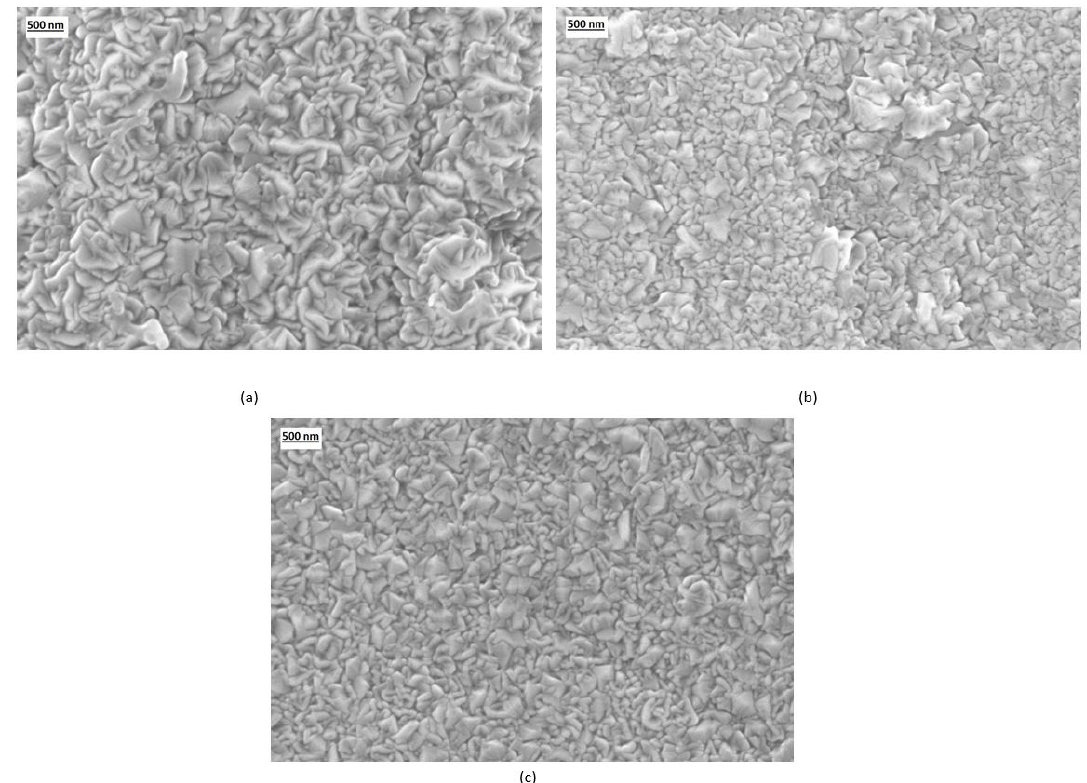
Figure 3. Morphology of AZO coatings prepared at (a) 33%, (b) 43%, and (c) 50% argon partial